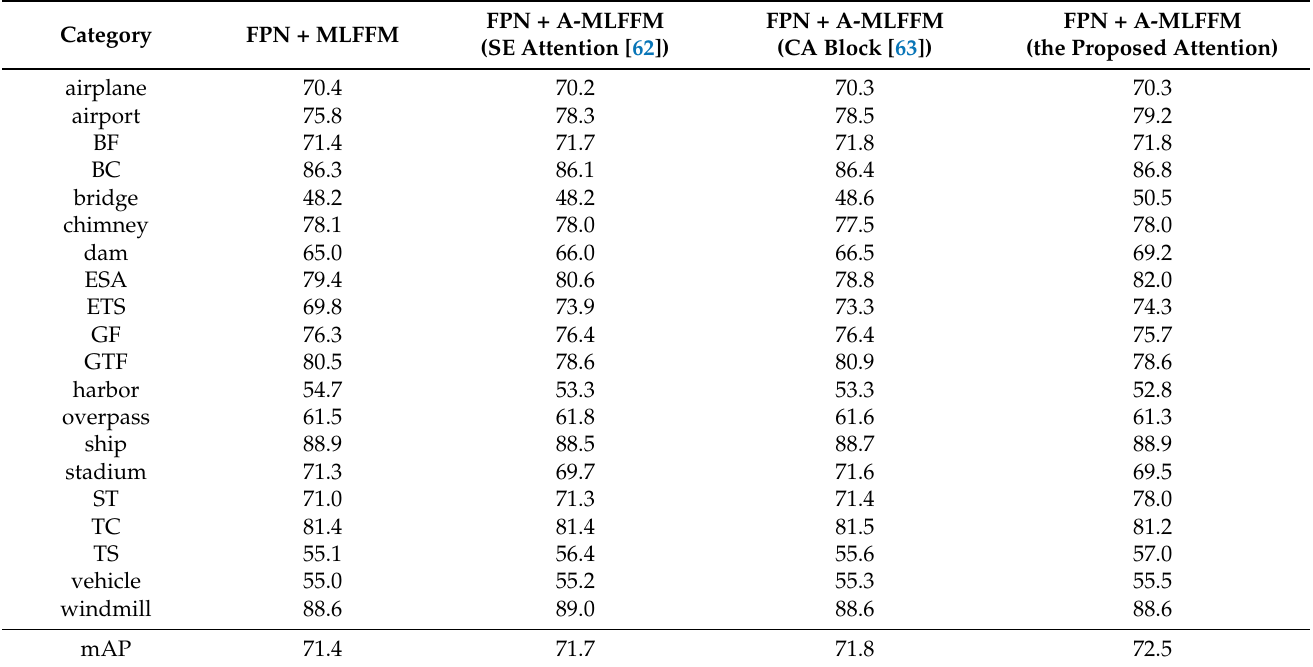
Table 2. Detection accuracy comparison between FPN with MLFFM and FPN with A-MLFFM containing different attention modules on the DIOR